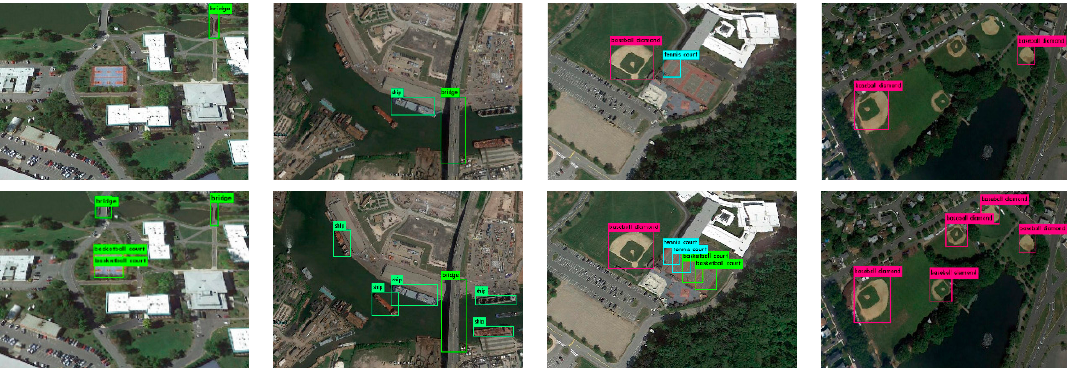
Figure 7. The comparison of intersection over union (IOU) curves obtained by two networks: ( a ) YOLOv3-tiny network; ( b ) TF-YOLO network.